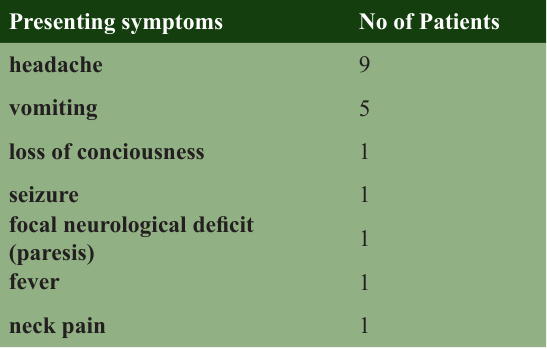
Table 1: Presenting symptoms (No of Patients) Presenting symptoms No of Patients